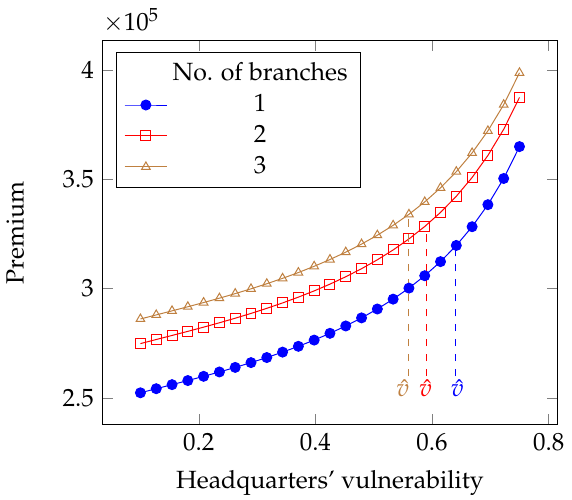
Figure 6. Impact of the intrinsic vulnerability on the premium in the full liability case.